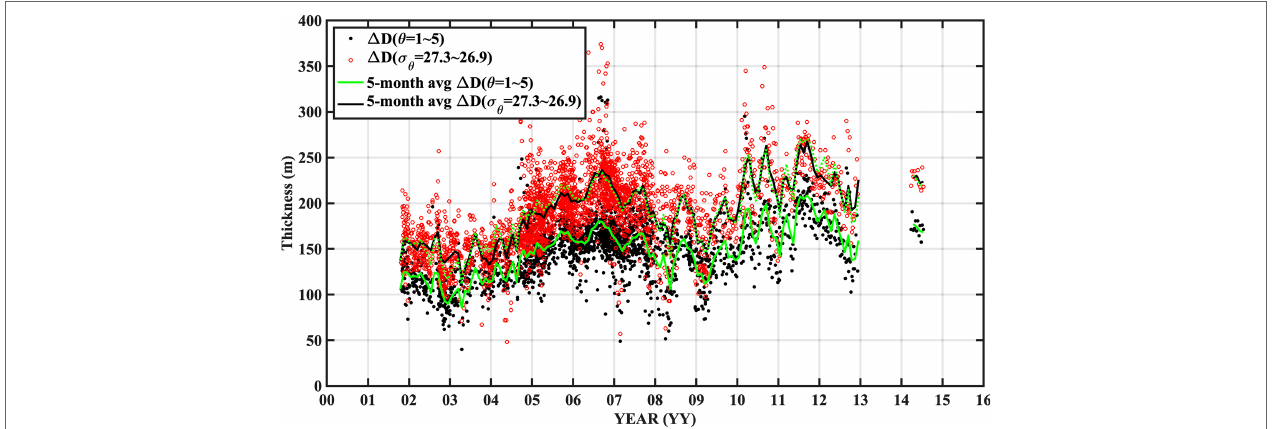
FIGURE 3 | Time series of temperature-based thickness and density-based thickness in the area denoted by the dashed line ( Figure 1B ). Black and open red dots denote temperature- and density-based thickness, respectively. Green and black lines show the 5-month moving averages of the temperature-based and density- based thickness, respectively. The green dotted line represents 1.3 times the temperature-based